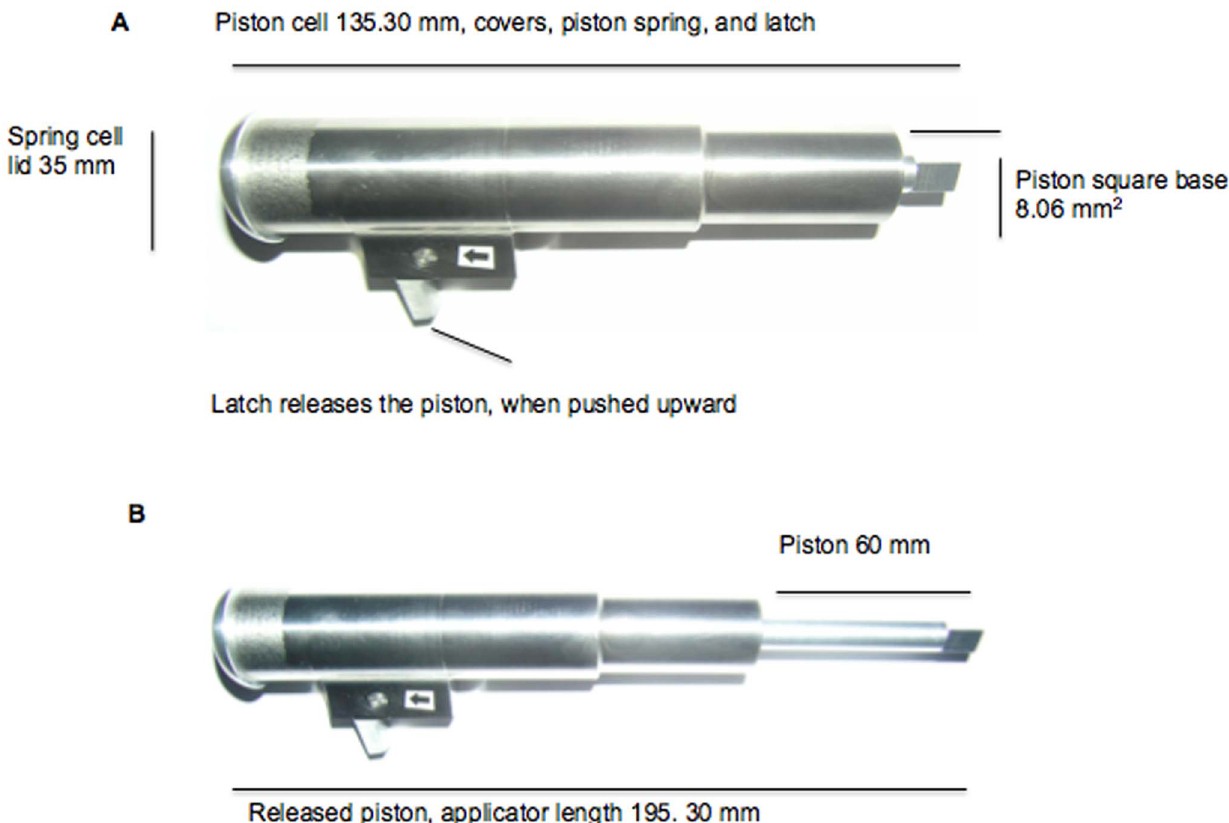
Figure 1. Illustration of the metal applicator used for the MN applications. ( A ) A digital photograph of the applicator prior to release of the piston. ( B ) A digital photograph of the applicator after the release of the piston. The digital images were captured using an Olympus C5060 WZ digital camera (Olympus Corporation, Lake Success, NY, USA) and were edited with Adobe H Photoshop H CS5 (Extended Version 12.0 6 64, Adobe Systems Inc., San Jose, CA, USA).